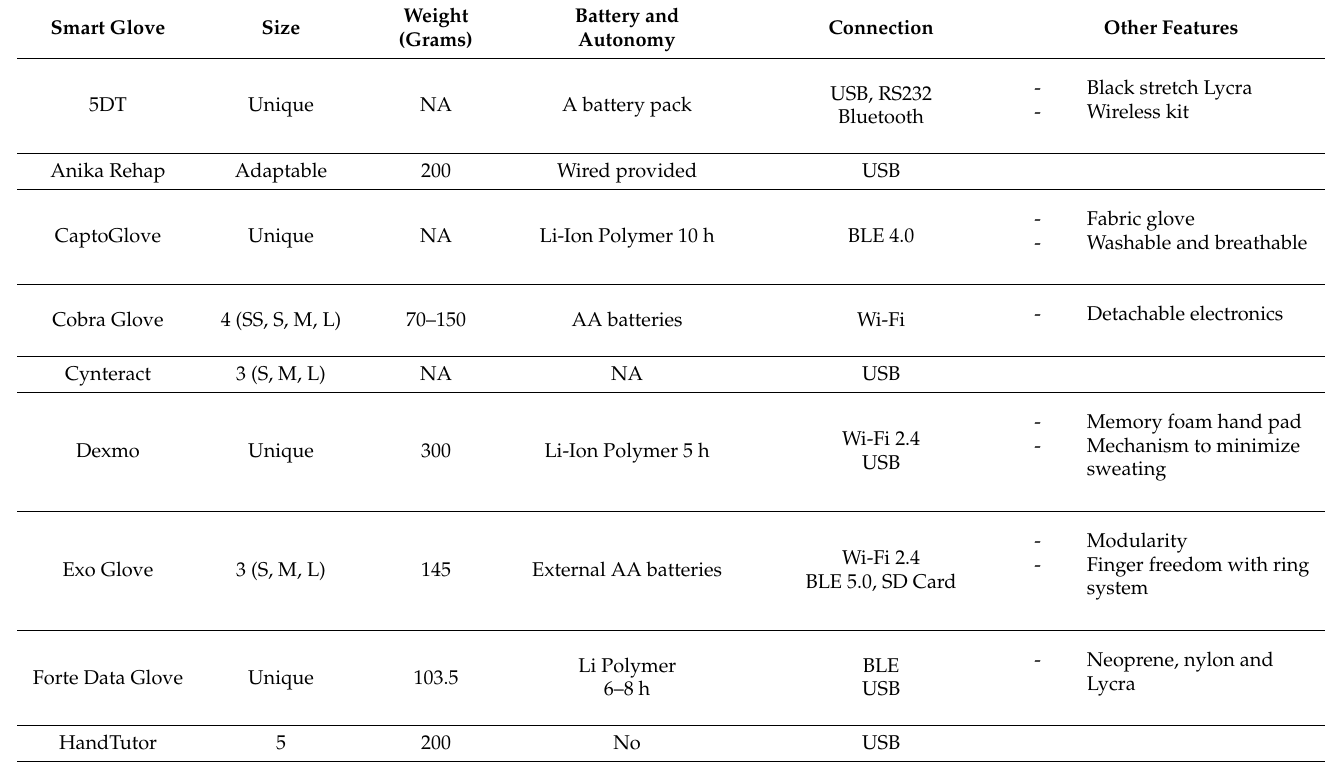
Table 3. Ergonomics and wearability features in commercial smart